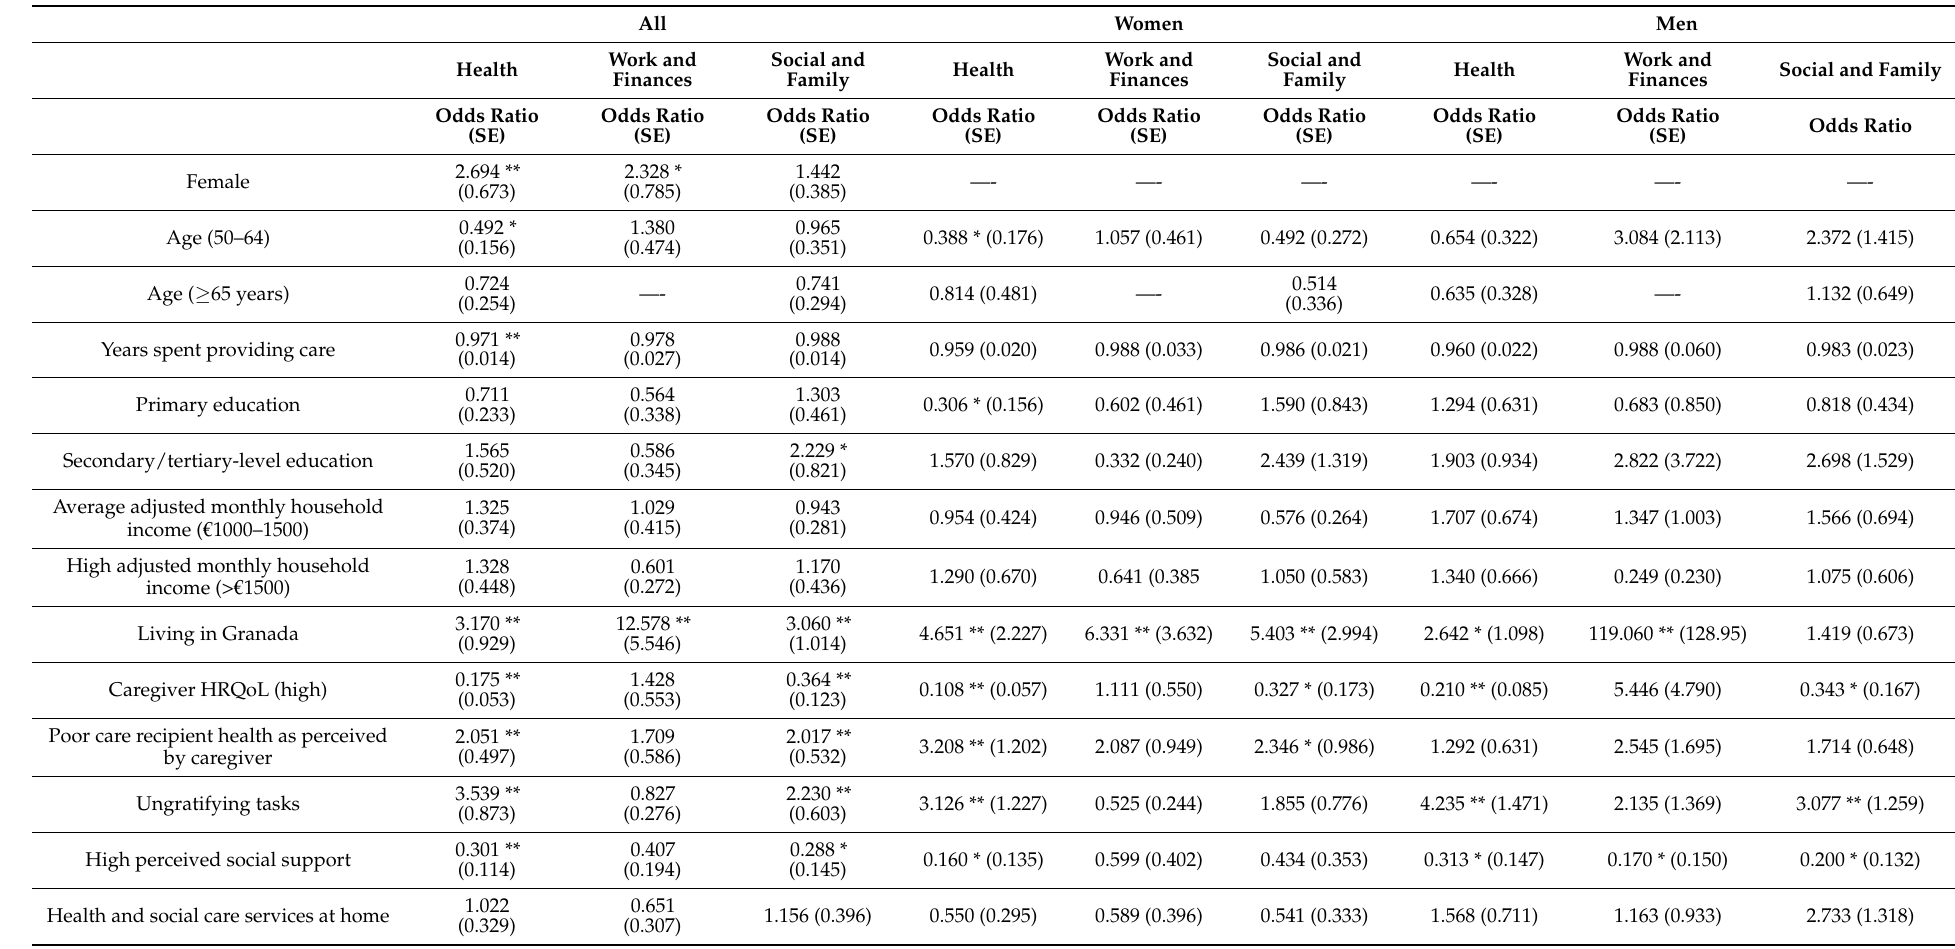
Table 3. Multivariate analysis of problems attributed to caregiving by full sample and men and women